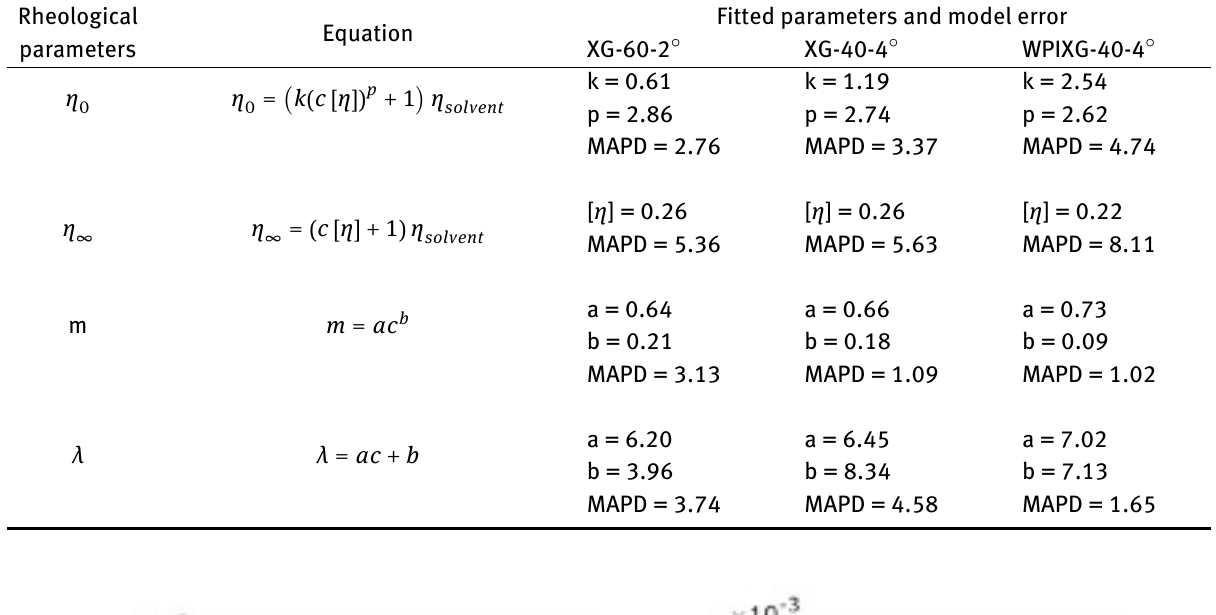
Table 3: Model equations and fitted parameters for the correlations of the rheological parameters with polymer concentration. Adjustment of models in terms of MAPD (mean absolute percent deviation).